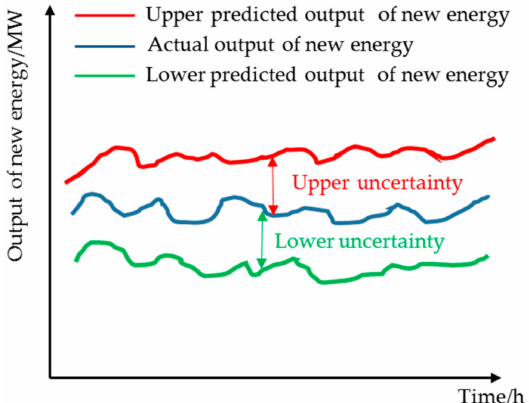
Figure 4. The description of upper and lower